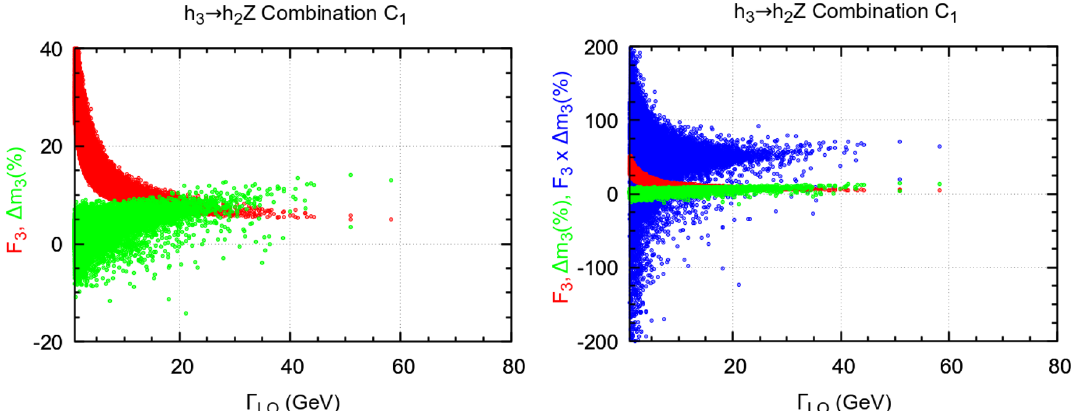
for the combination C 1 . Right: h 3 → h 2 Z